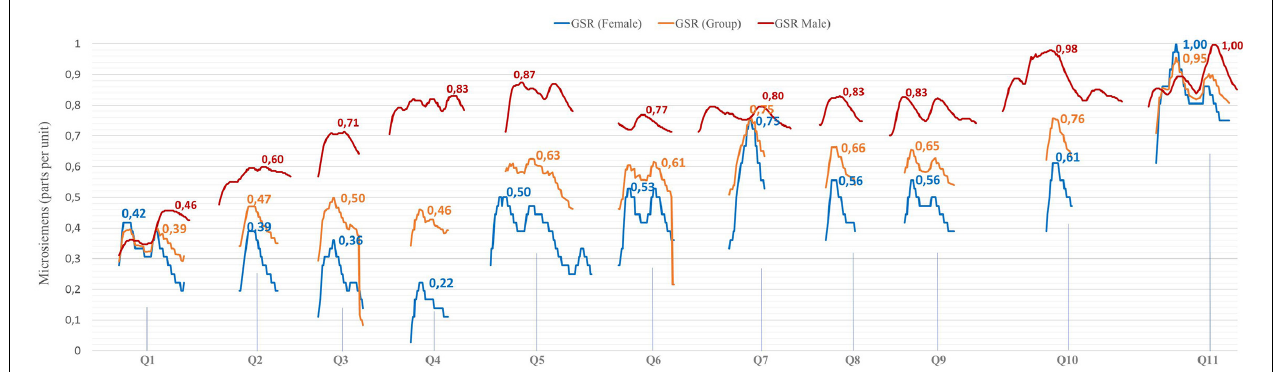
FIGURE 4 | GSR peaks for each question. Group and by gender. Source: Prepared by the